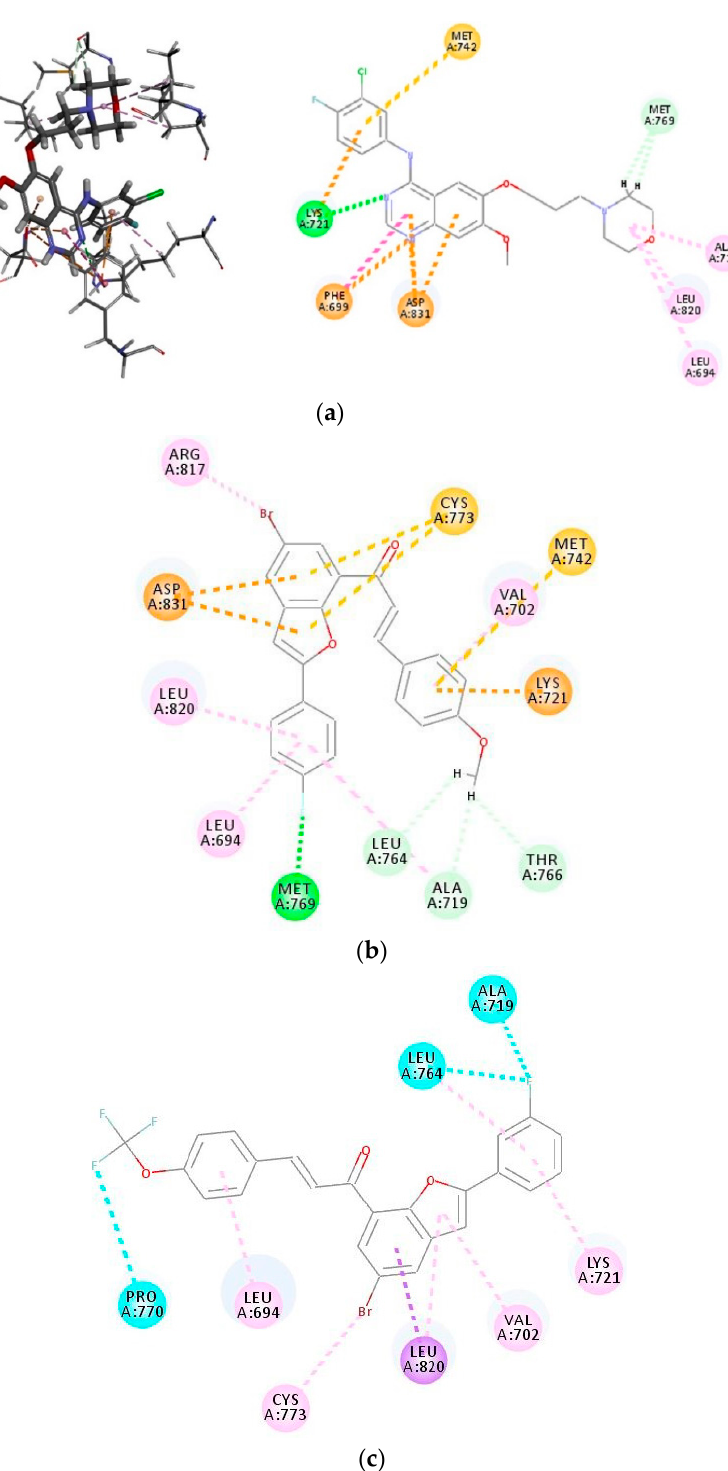
Figure 7. ( a ) 2D interaction diagrams for the binding of EGFR (PDB code 1M17) with gefitinib; ( b ) the structure of ( E )-1-(5-Bromo-2-(4-fluorophenyl)benzofuran-7-yl)-3-(4-methoxyphenyl)prop-2-en-1-one ( 3i ); ( c ) the structure of E )-1-(5-Bromo-2-(3-fluorophenyl)benzofuran-7-yl)-3-(4-(trifluoromethoxy)phenyl)prop-2-en-1-one ( 3o ). Residues are annotated with their three-letter amino acid code.